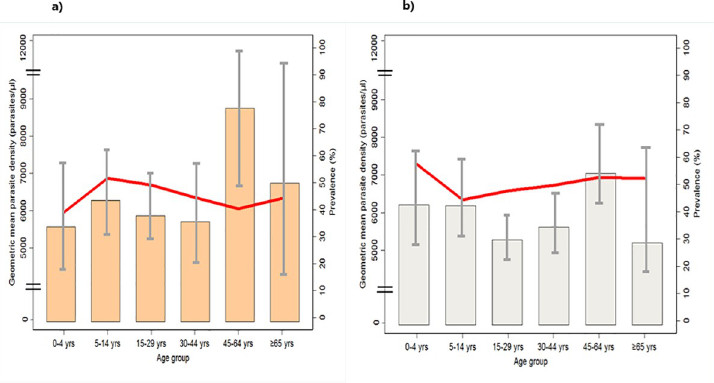
Fig 2. Prevalence of malaria and geometric mean parasite densities according to the infecting species. a) Age- specific prevalence of malaria and geometric mean parasite densities in P . falciparum . Line indicates prevalence of malaria. Bars indicate geometric parasite density and 95% confidence interval. b) Age-specific prevalence of malaria and geometric mean parasite densities in P . vivax . Line indicates prevalence of malaria. Bars indicate geometric parasite density and 95% confidence